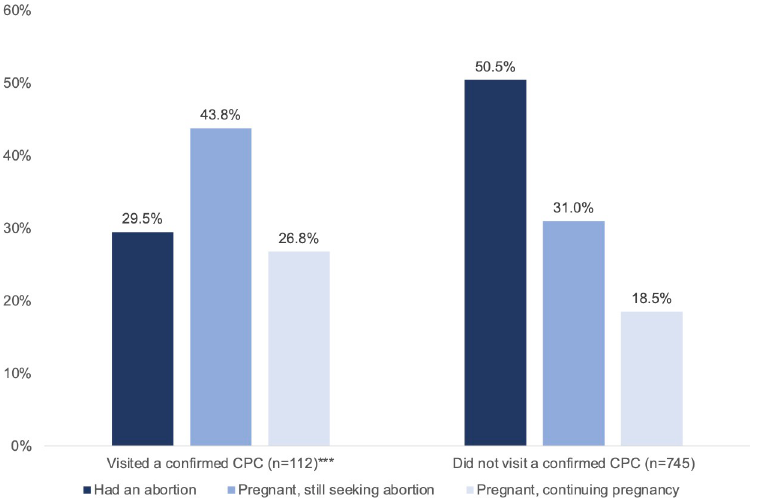
Fig 3. Pregnancy and abortion outcomes at follow-up survey, by confirmed CPC visit. ��� p < 0.001.